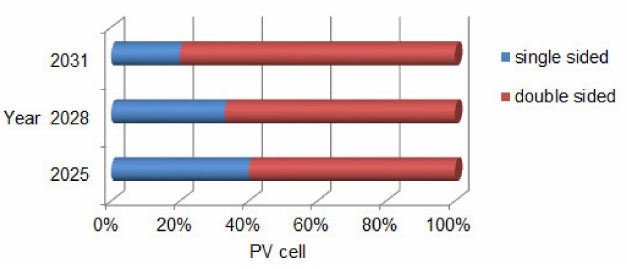
Figure 1. The market dominance of single-double-sided contact concepts [3].